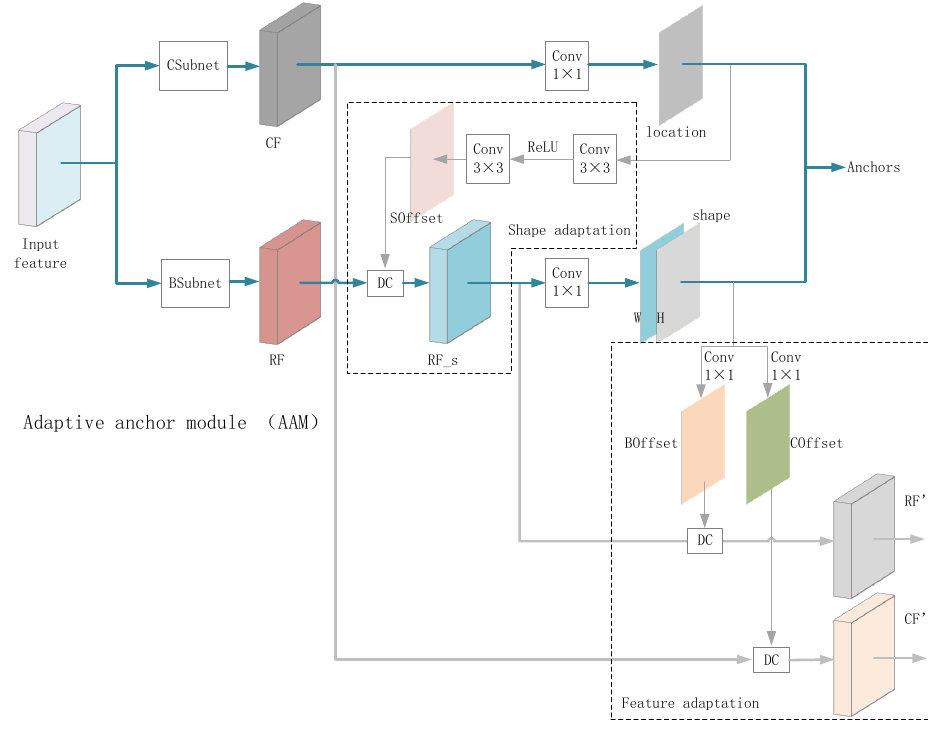
Figure 5. Adaptive anchor module